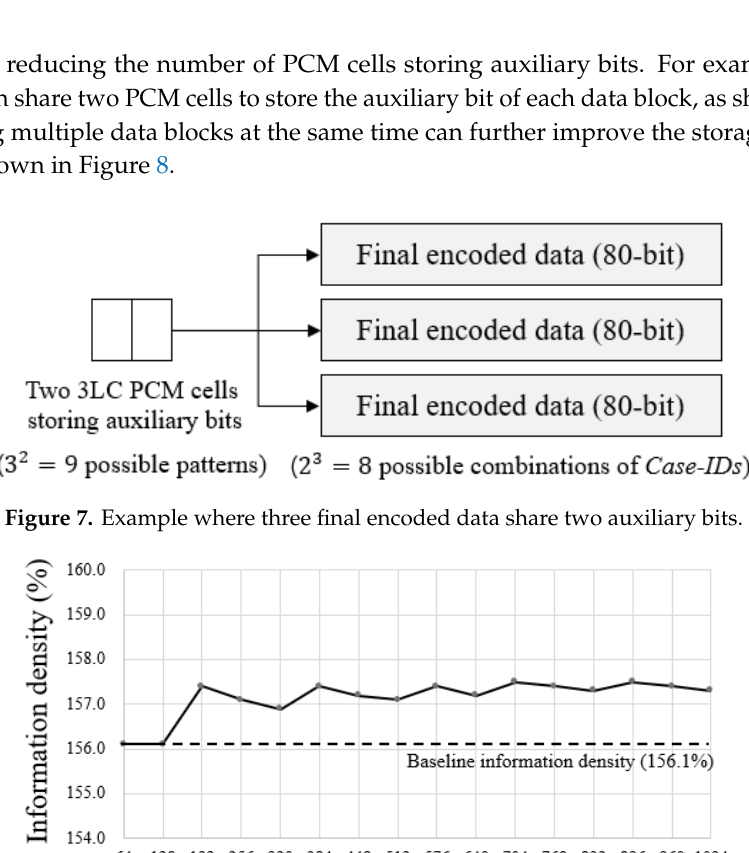
Table 5. Simulation parameters.